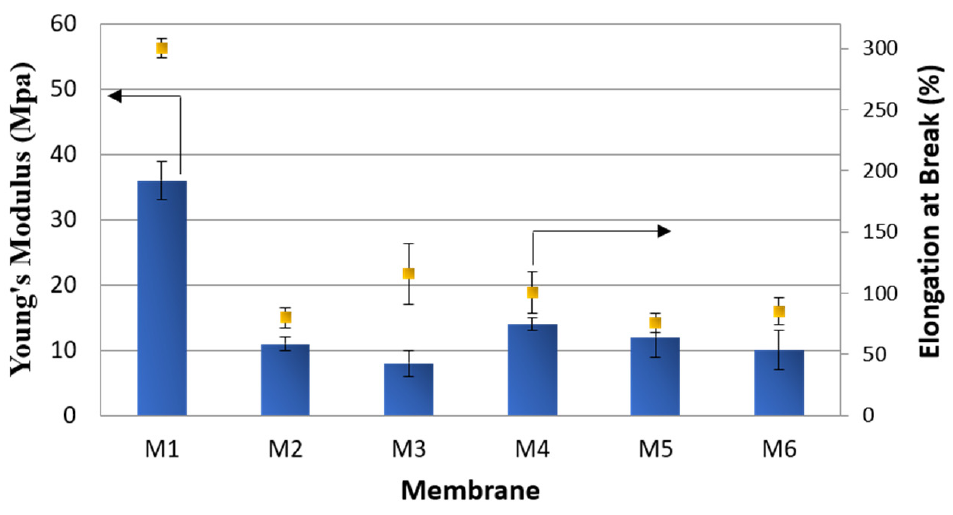
Figure 5. Mechanical properties of M1–M6 membranes.